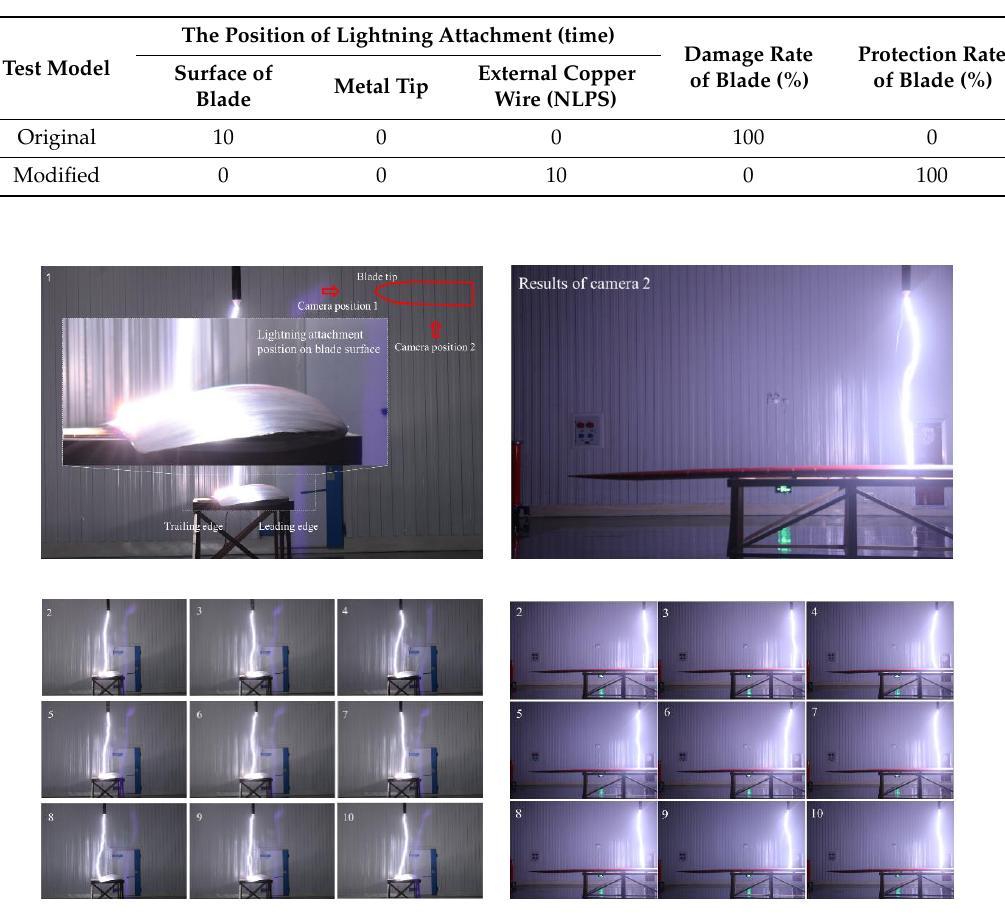
Table 1. The result of the discharge test under the negative standard lightning impulse